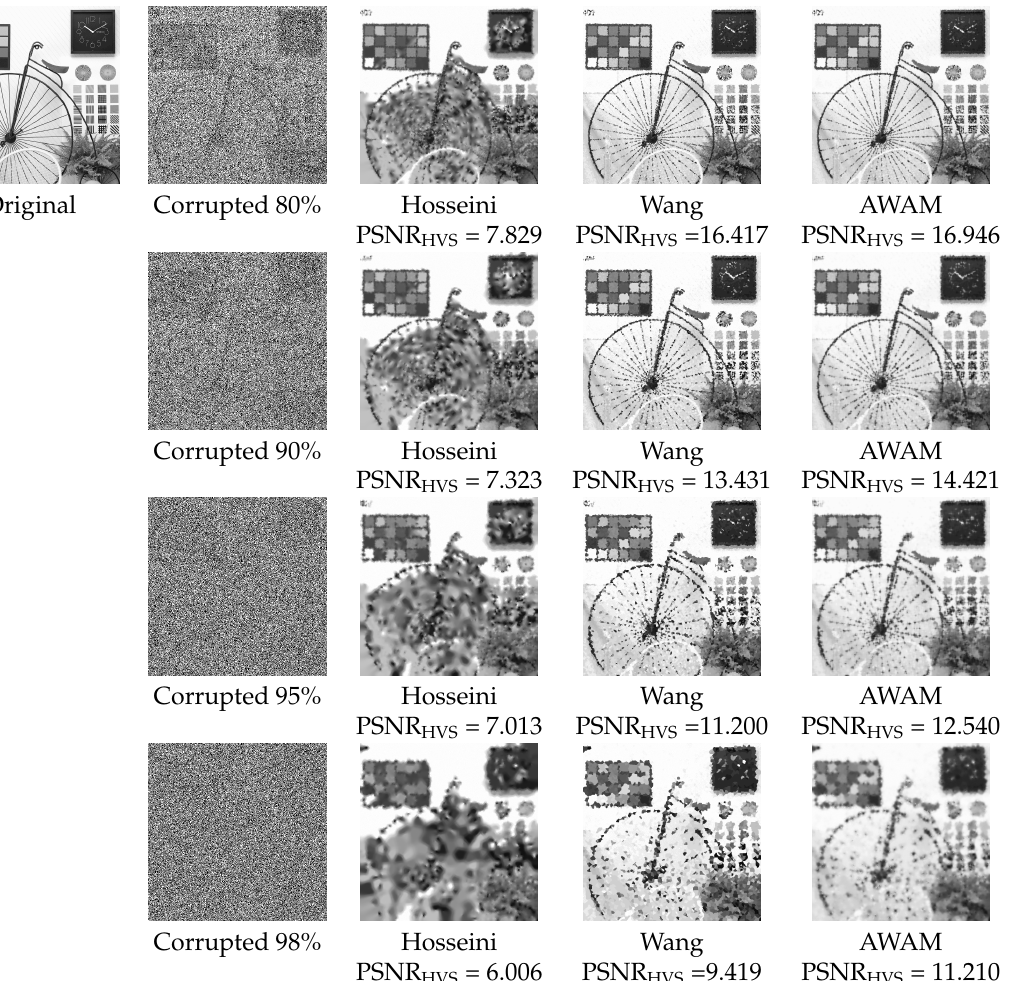
Figure 7. Restoration results, including the PSNR HVS values, of Hosseini, Wang and AWAM filters for the original image I11.tiff (bycicle test image) corrupted with 80%, 90%, 95% and 98%